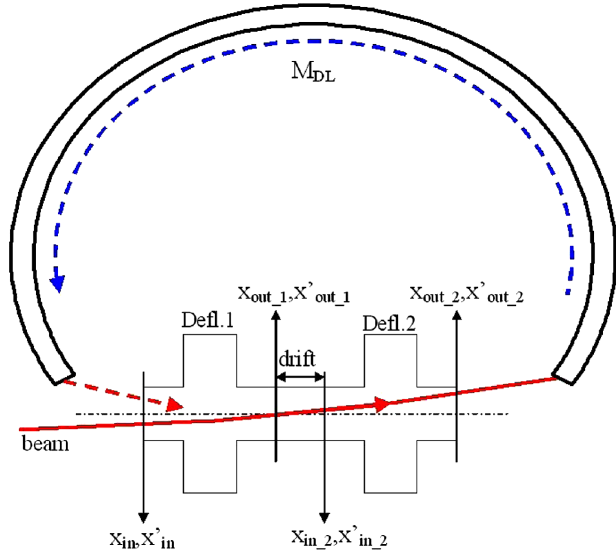
FIG. 13. (Color) Tracking code scheme. The red lines represent the particle trajectories. Each bunch enters the deflecting system with some horizontal initial conditions ð x in ; x 0 in Þ , interacts with both the main rf deflecting fields and the wakes left by the bunches ahead, contributes to the wake, and exits from the deflectors with some new horizontal conditions ð x out